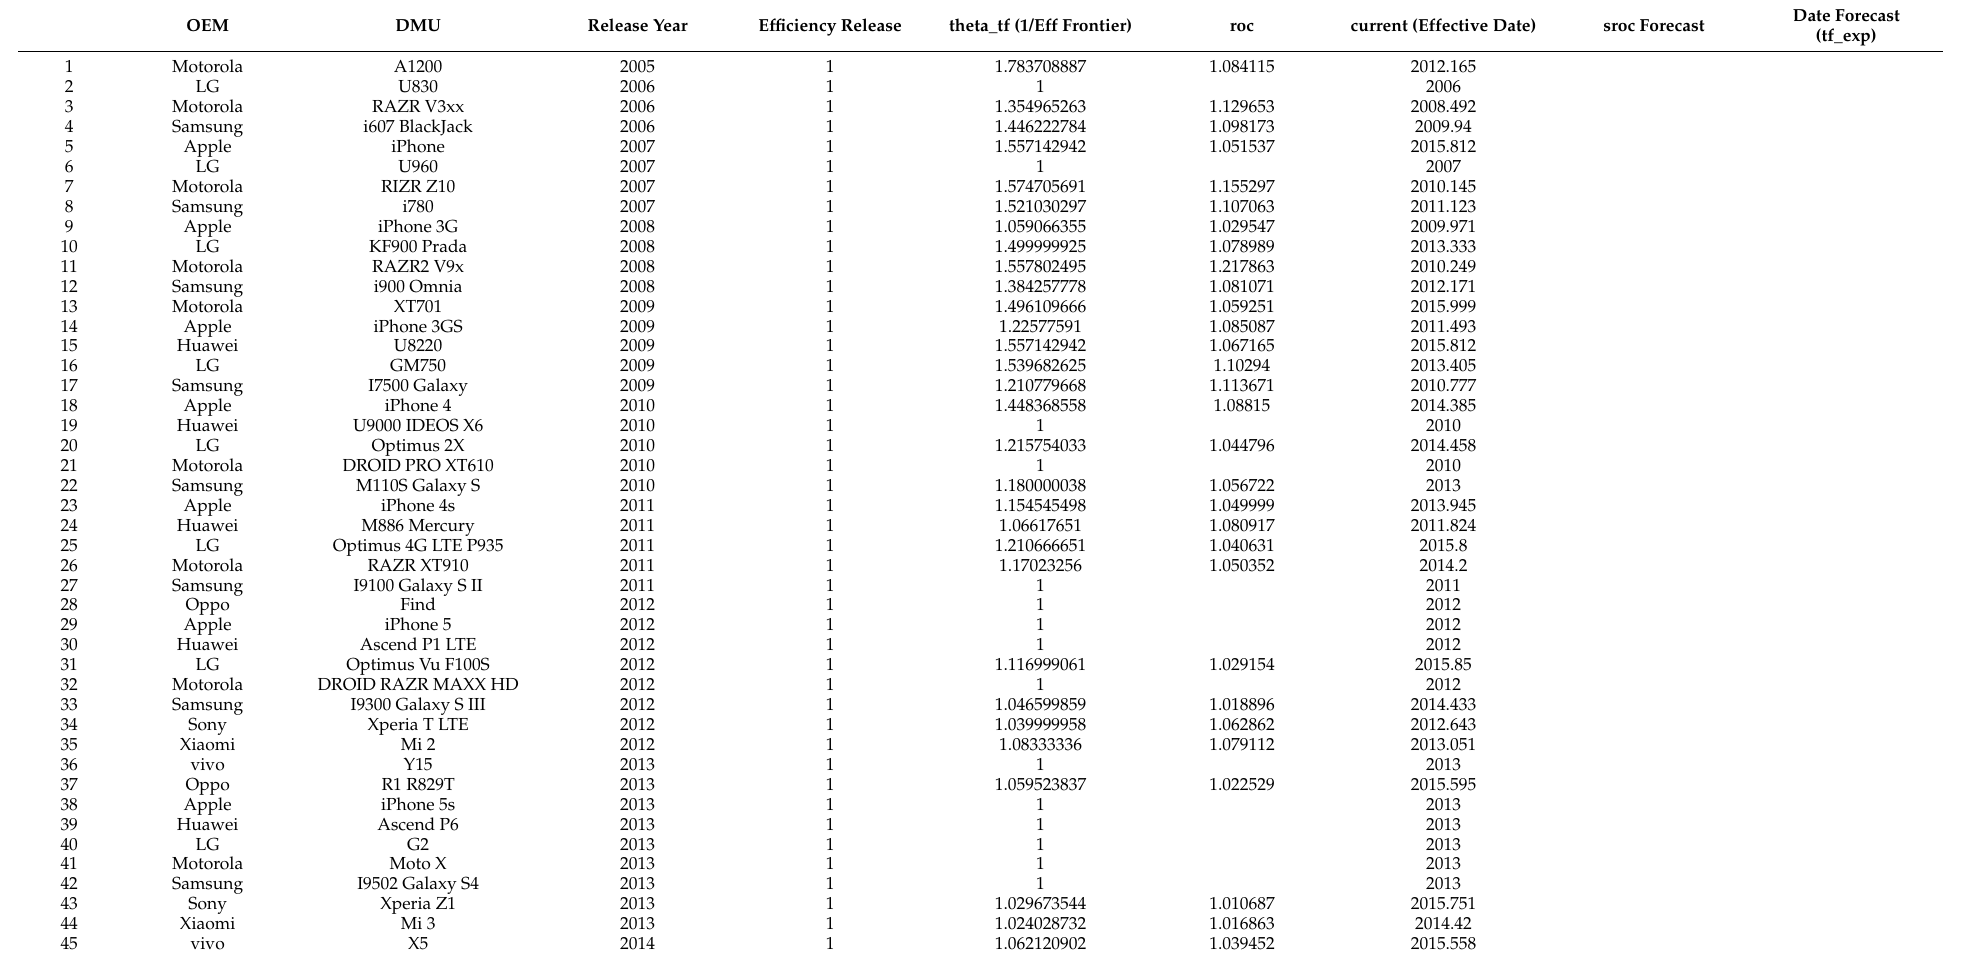
Table 3. Model forecasting results of smartphones with tf (2017)